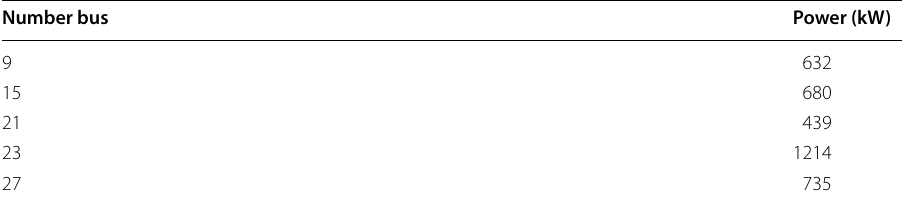
Table 3 Parameters of placement and sizing under the output power factor of 0.85 pre-phase in the 33-bus